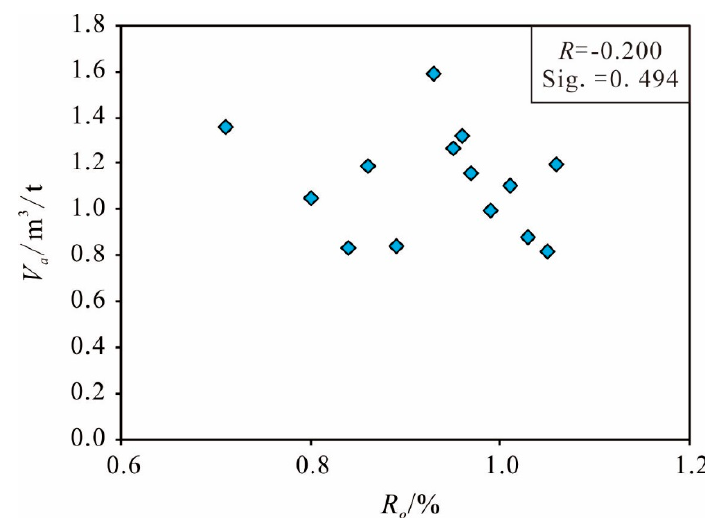
Figure 11. Relationship between V a and thermal maturity R o of the shale samples.